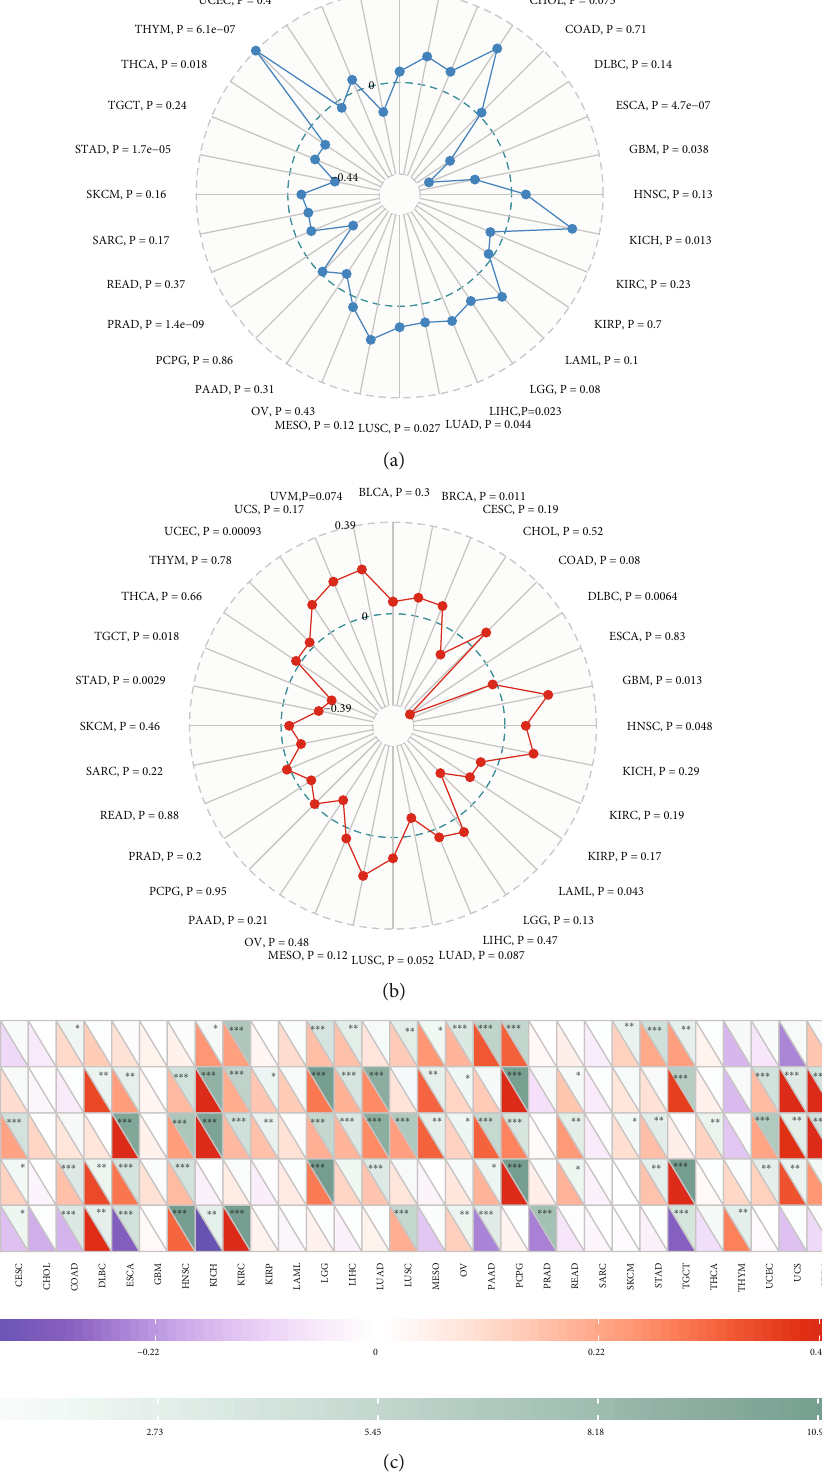
Figure 9: (a) The radar chart showed the correlation of B4GALNT1 expression with TMB across multiple cancers. (b) The radar chart showed the correlation of B4GALNT1 expression with MSI across multiple cancers. (c) The heat map showed the correlation of CTSL expression with the expression levels of fi ve MMR genes across cancers. ∗ P < 0 : 05 , ∗∗ P < 0 : 01 , and ∗∗∗ P < 0 : 001